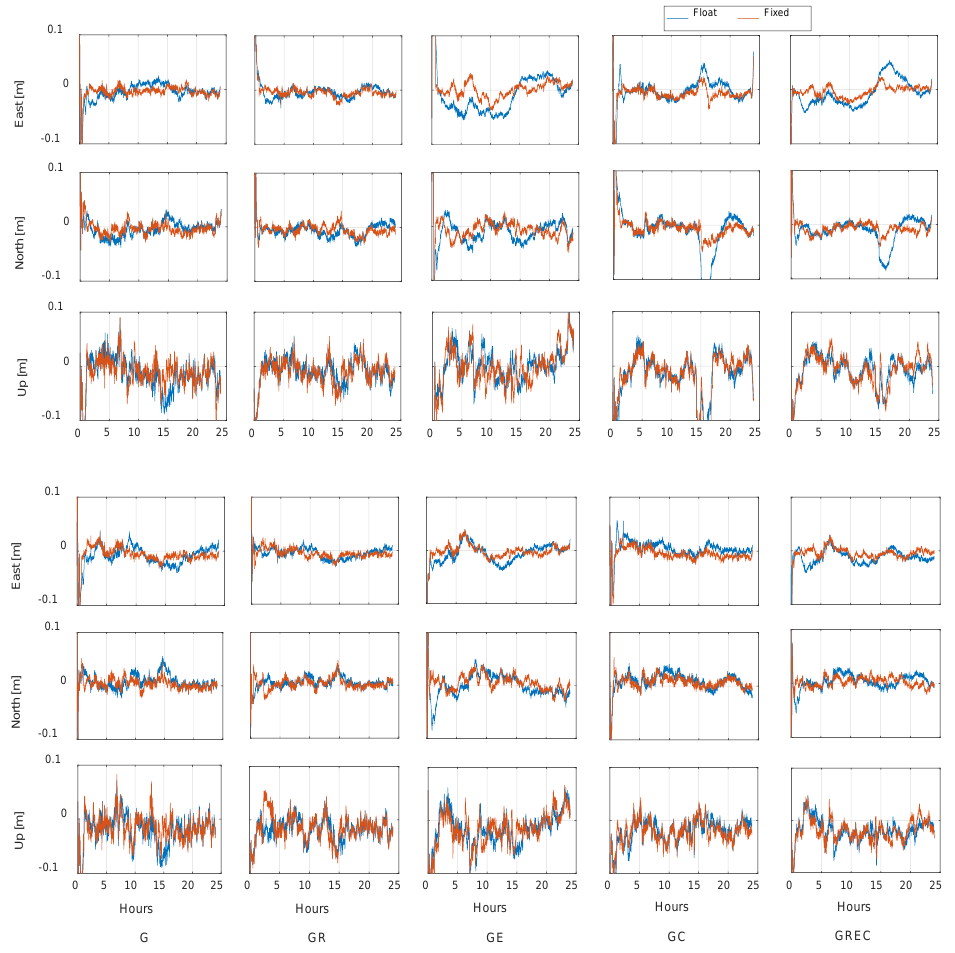
Figure 5. The single-, dual- and four-system PPP (upper half) and POP (lower half) float and fixed solutions with respect to the IGS nominal position for station CAS1 on 1 January 2018. We can see better performance of POP than PPP with BDS involved solutions.